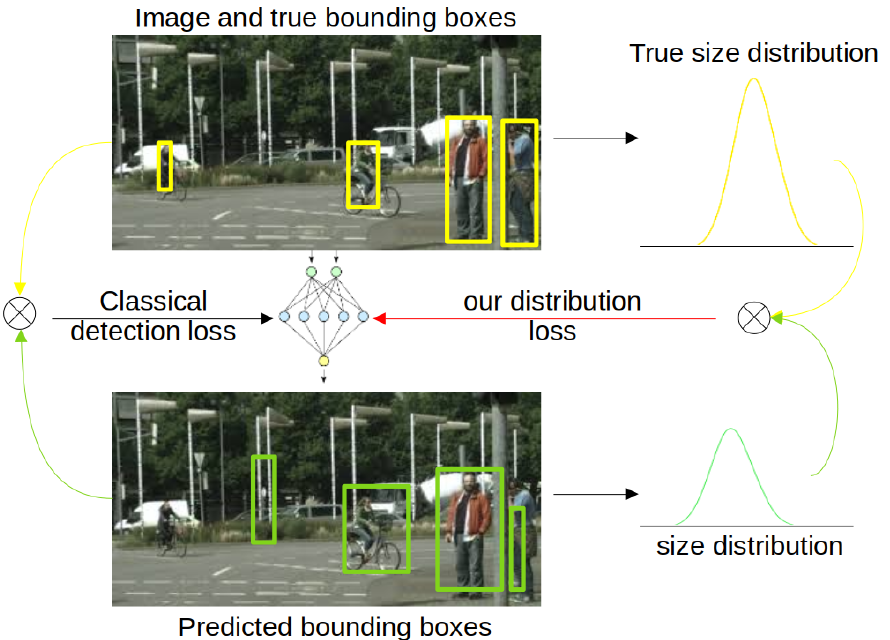
Figure 2. Overview of our approach for size-based sub-populations. Baseline detector is trained with classical loss ( left of the figure). However, in this paper, we focus on extracting the size distribution of objects by efficiently back-propagating the metric on distributions into the deep network ( right of the